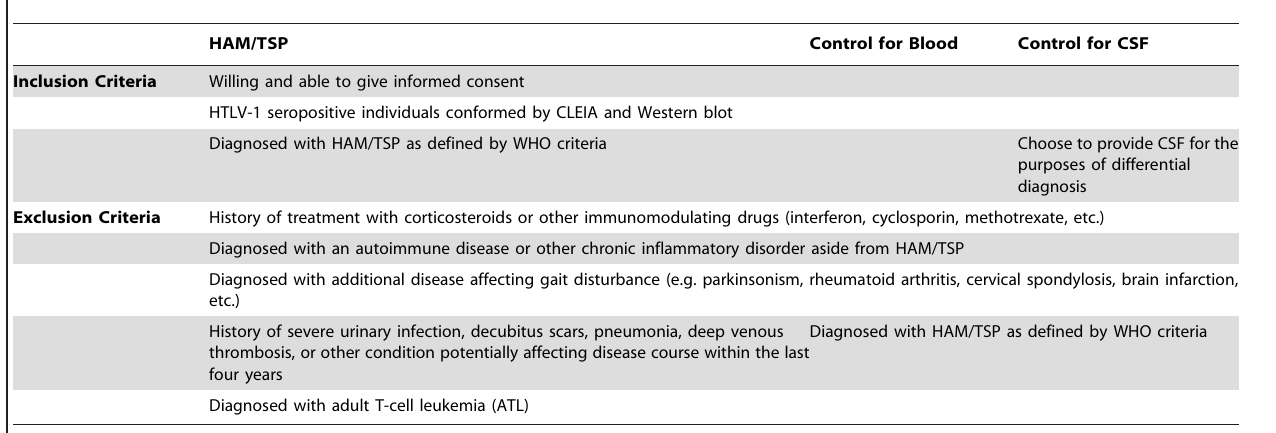
Table 1. Inclusion and exclusion criteria for this study.